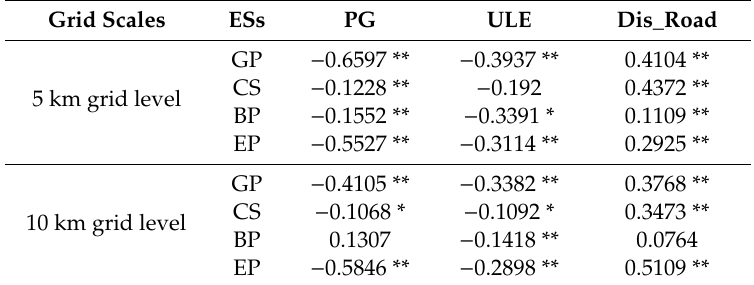
Table 2. Coefficients between ecosystem services (ESs) changes and urbanization indicators from ordinary least squares.